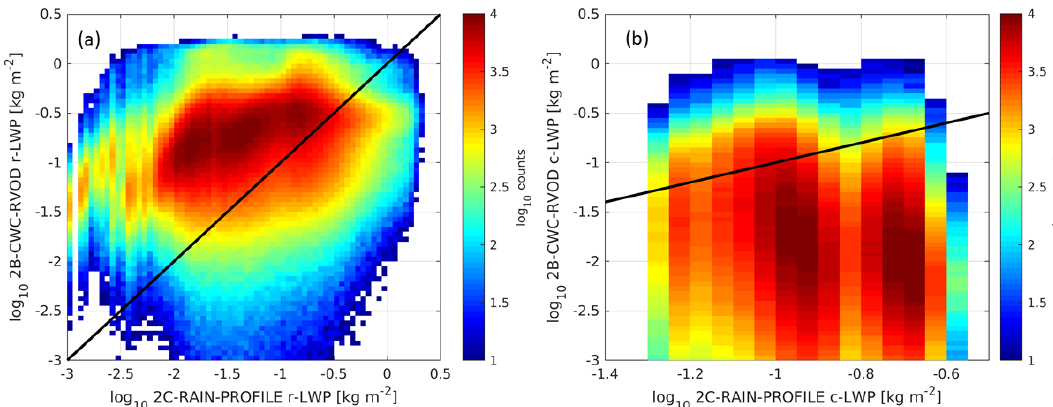
Figure 4. Comparisons of the (a) rain LWP (r-LWP) and (b) cloud LWP (c-LWP) during warm rain (from 2007 to 2010, daytime only) for two CloudSat retrieval algorithms, 2B-CWC-RVOD and 2C-RAIN-PROFILE. Black lines correspond to the 1 : 1 line; evidence of correlation between the values obtained from the two CloudSat products is minimal.